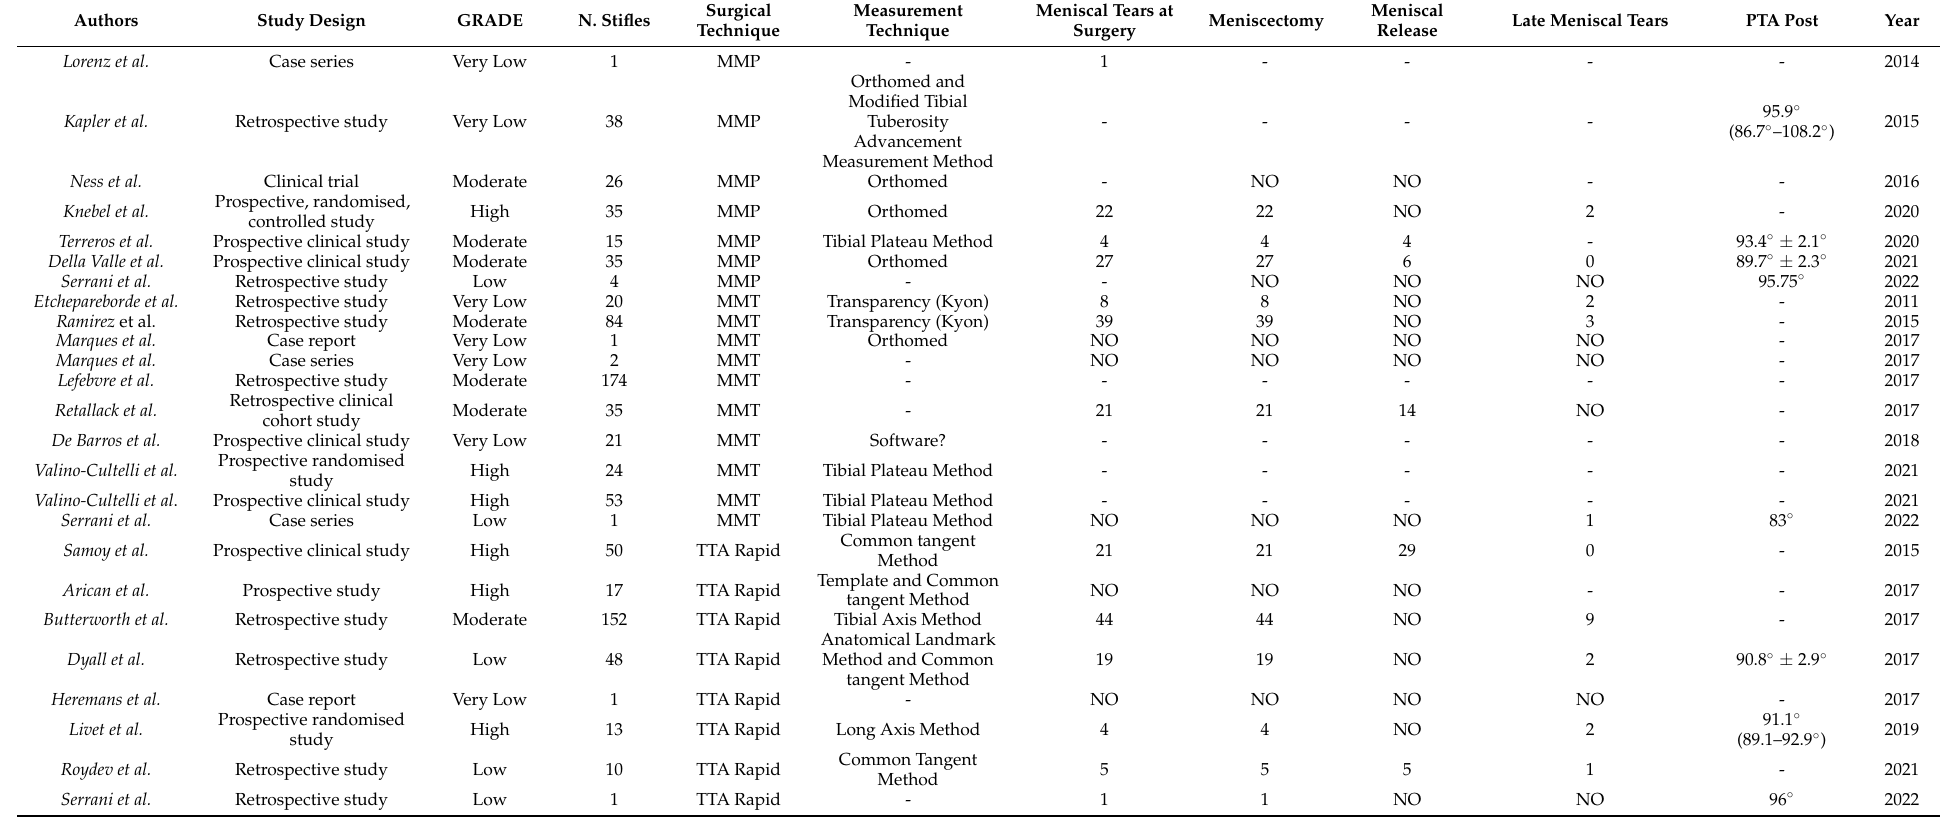
Table 1. List of reviewed papers: study details, sample size, surgical planning, and meniscal